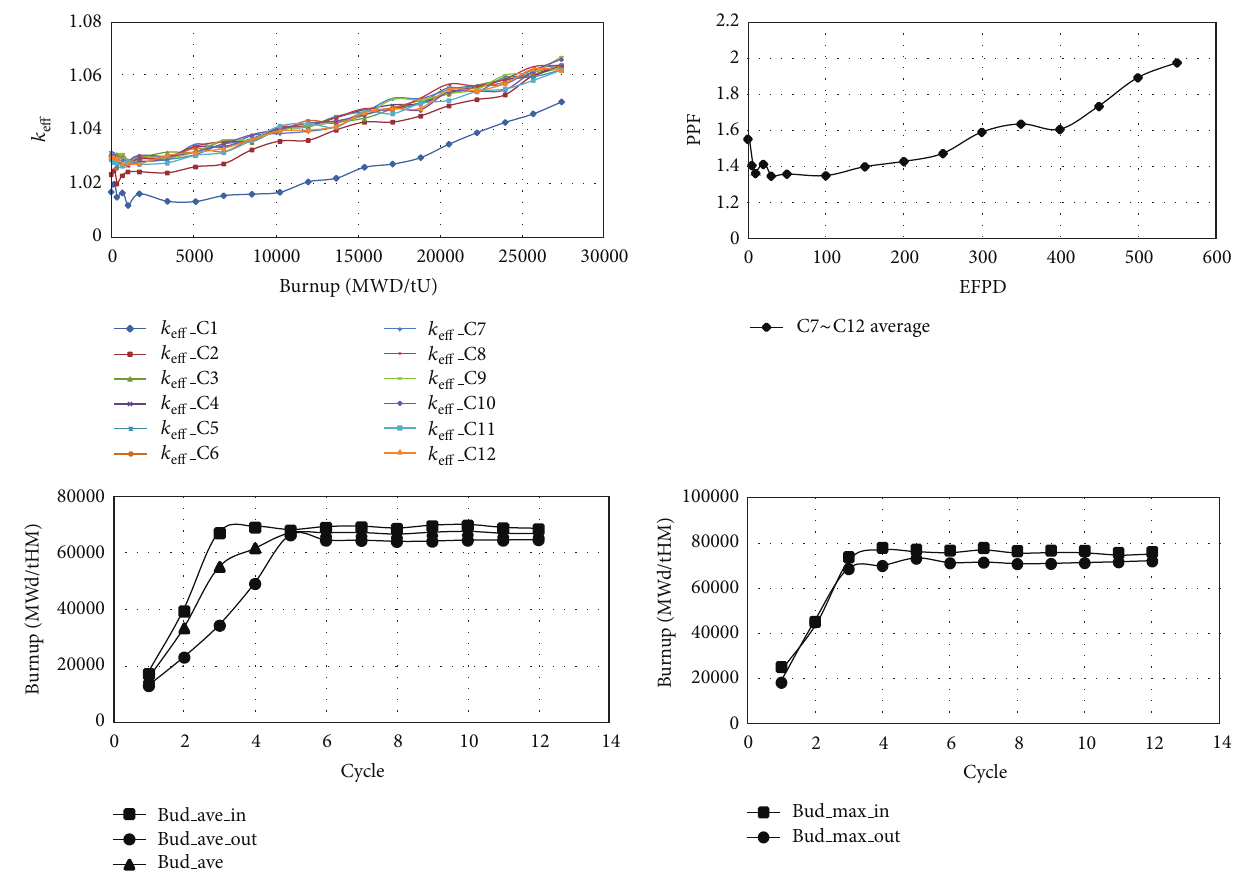
Figure 12: Multicycle burnup simulation results for Th-MOX+DU-MOX